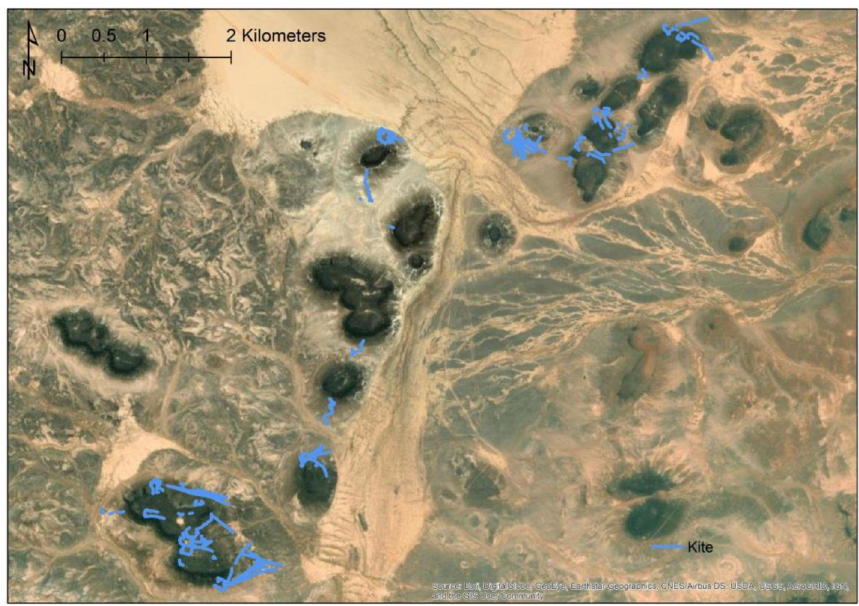
Figure 14. Overview of kites in the survey region. Kites spread along the mesas, and connect by walls or the natural topography of the mesas themselves. Basemap source: Esri, DigitalGlobe, GeoEye, Earthstar Geographics, CNES/Airbus DS, USDA, USGS, AeroGRID, IGN, and the GIS User